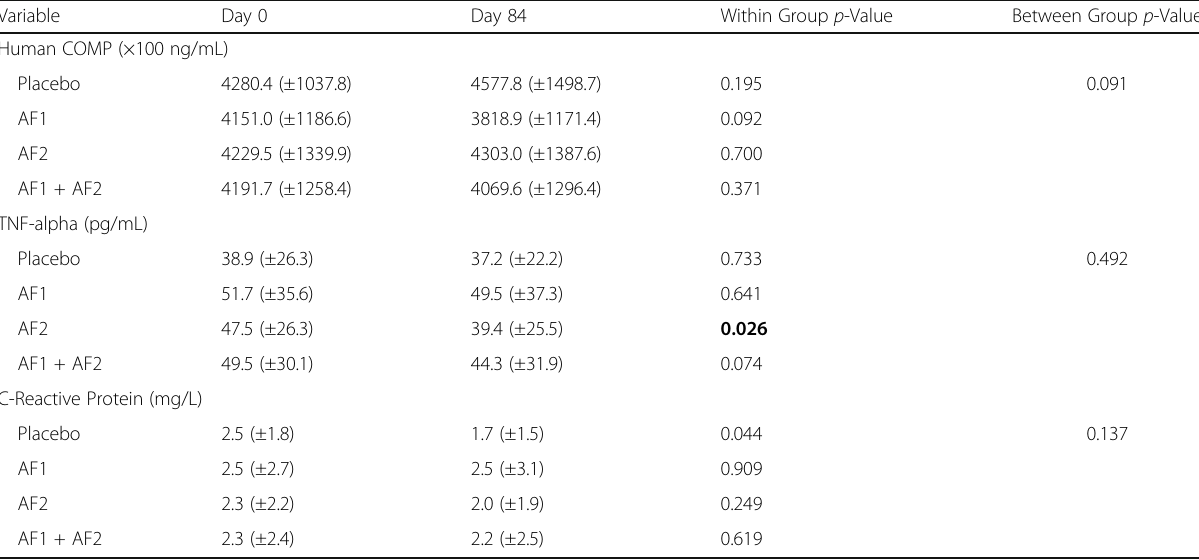
Table 9 Measures of inflammatory markers